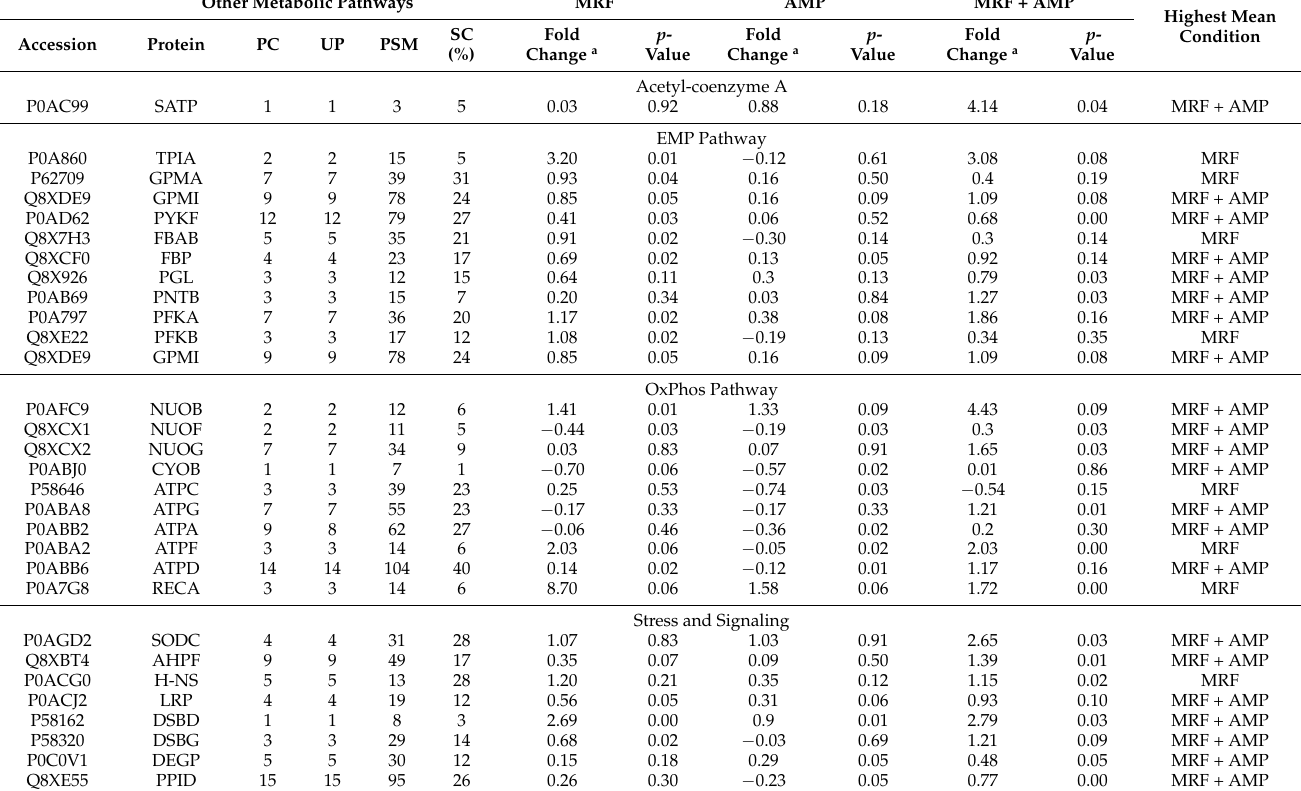
Table 2. The influence of MRF (1 mgmL − 1 ) and antibiotic treatment (0.1 mgmL − 1 AMP) on fold- change expression (normalized peptide abundance) of key components of central metabolic pathways relative to the